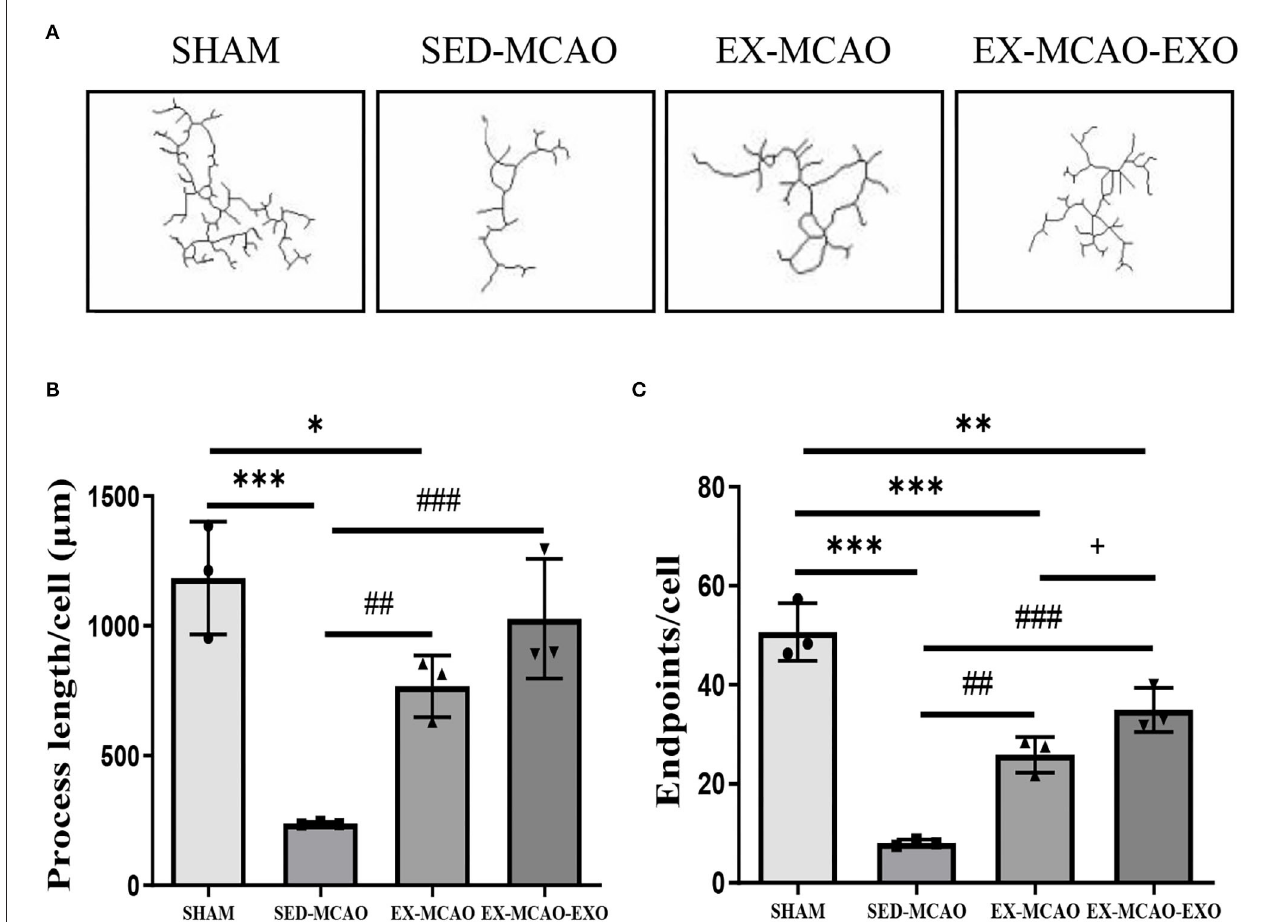
FIGURE 5 | Microglial morphological analysis. (A) Representative image of microglial skeletonization. (B) Process length/cell. (C) End point/cell. * P < 0.05, ** P < 0.01, and *** P < 0.001 compared with the SHAM group; ## P < 0.01 and ### P < 0.001 compared with the SED-MCAO group; + P < 0.05 compared with the EX-MCAO group. Mean ± standard deviation. N =